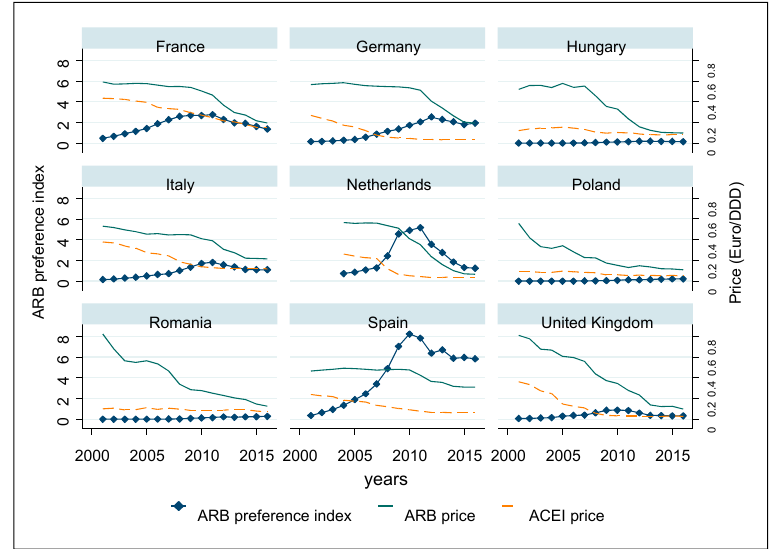
Figure 2. ARB preference index and average ARB and ACEI